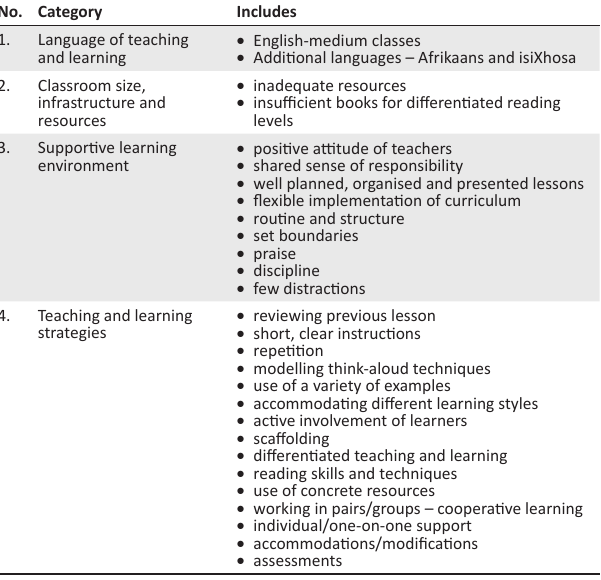
TABLE 2: Synthesised categories of the emergent